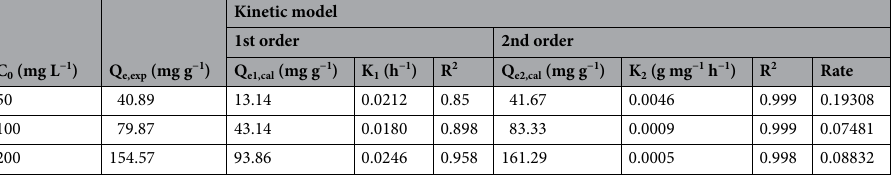
Table 3. Parameters of the 1st and 2nd-order kinetic models for adsorption of KMnO 4 by Ox-FVESP.